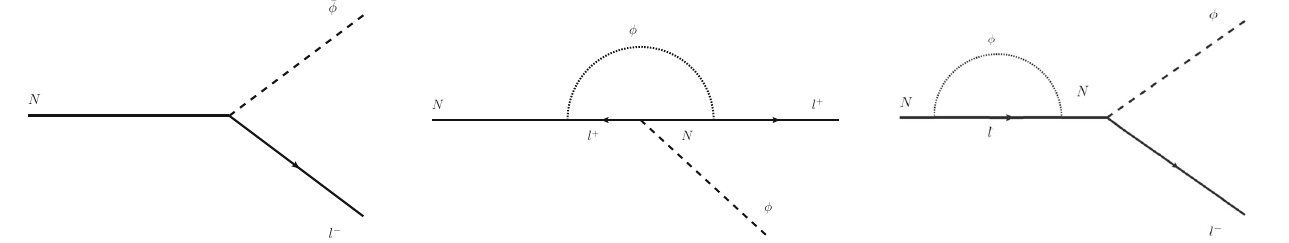
Fig. 1 Tree-(left)andone-loop(right)decayamplitudesforthedecays (9) that are relevant for leptogenesis. Continuous undirected lines rep- resent right-handed neutrinos (RHN), lines with an arrow represent SM leptons, whilst dashed lines correspond to the SM Higgs. In our approach, only the tree diagrams are evaluated in the presence of an axial background field (7). The remaining diagrams are required for the standard result of [20], leading to leptogenesis in CPT invariant theo-